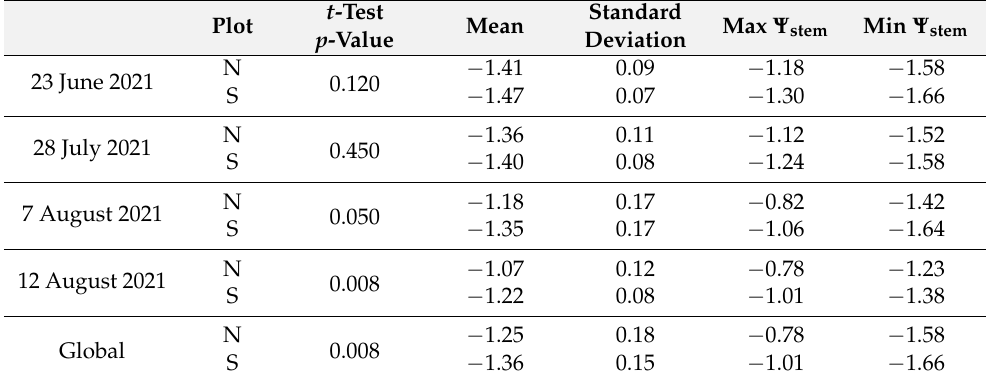
Table 4. The stem water potential differences (ground measures) between plots N and S. Compar- isons ( t -test) were carried out for both the single-date measures and globally (all dates were jointly considered). Standard deviation, and maximum and minimum values of Ψ stem measurements are also reported. Significance of tests was set at p < 0.05.